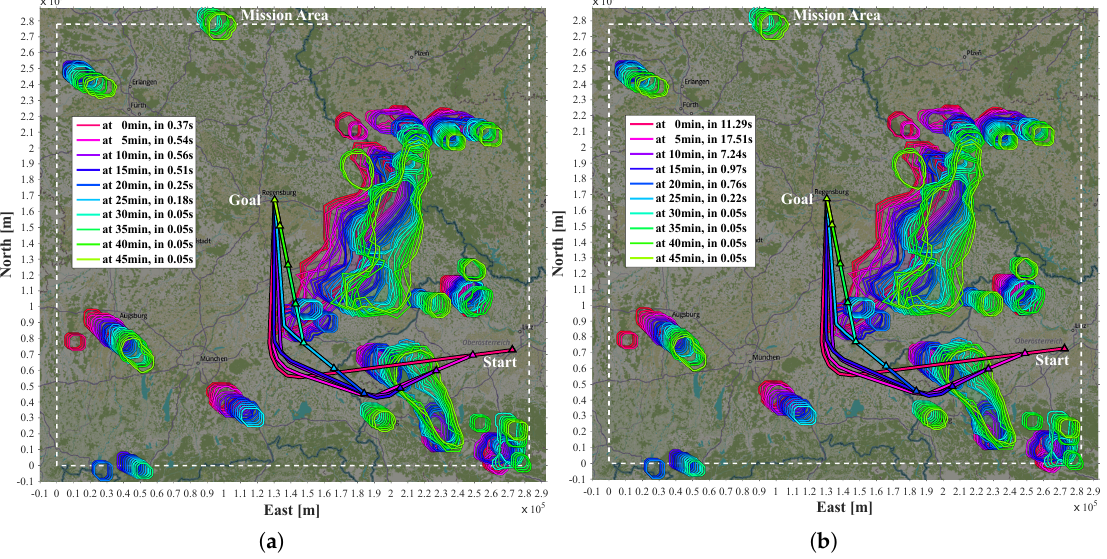
Figure 12. ( a ) Continuous avoidance using SSPH. ( b ) Continuous avoidance using